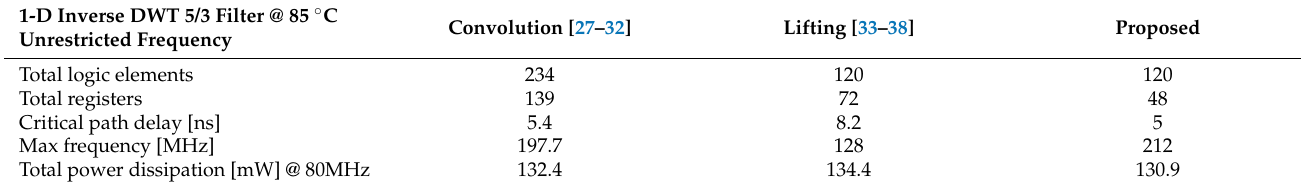
Figure 11. Block diagram of the proposed 1 ‐ D inverse 5/3 filter. Hardware realization of 1 ‐ D inverse 5/3 filter from Figure 9 has been implemented on EP4CE115F29C7 FPGA device from Altera Cyclone IVE family [71]. The synthesis results for the proposed non ‐ stationary filter realization and state ‐ of ‐ the ‐ art convolution ‐ based and lifting ‐ based realizations (implemented on the same FPGA device), obtained using Altera Quartus II 10.0 software, are presented in Table 7. It can be seen that hardware implementation of the proposed non ‐ stationary 1 ‐ D inverse 5/3 filter utilizes the lowest number of total logic elements and registers, has the FPGA synthesis results of various implementations of 5/3 filter on Altera FPGA shortest critical path delay, allows the highest maximum operating frequency and has the lowest total power dissipation in comparison with state ‐ of ‐ the ‐ art realizations.